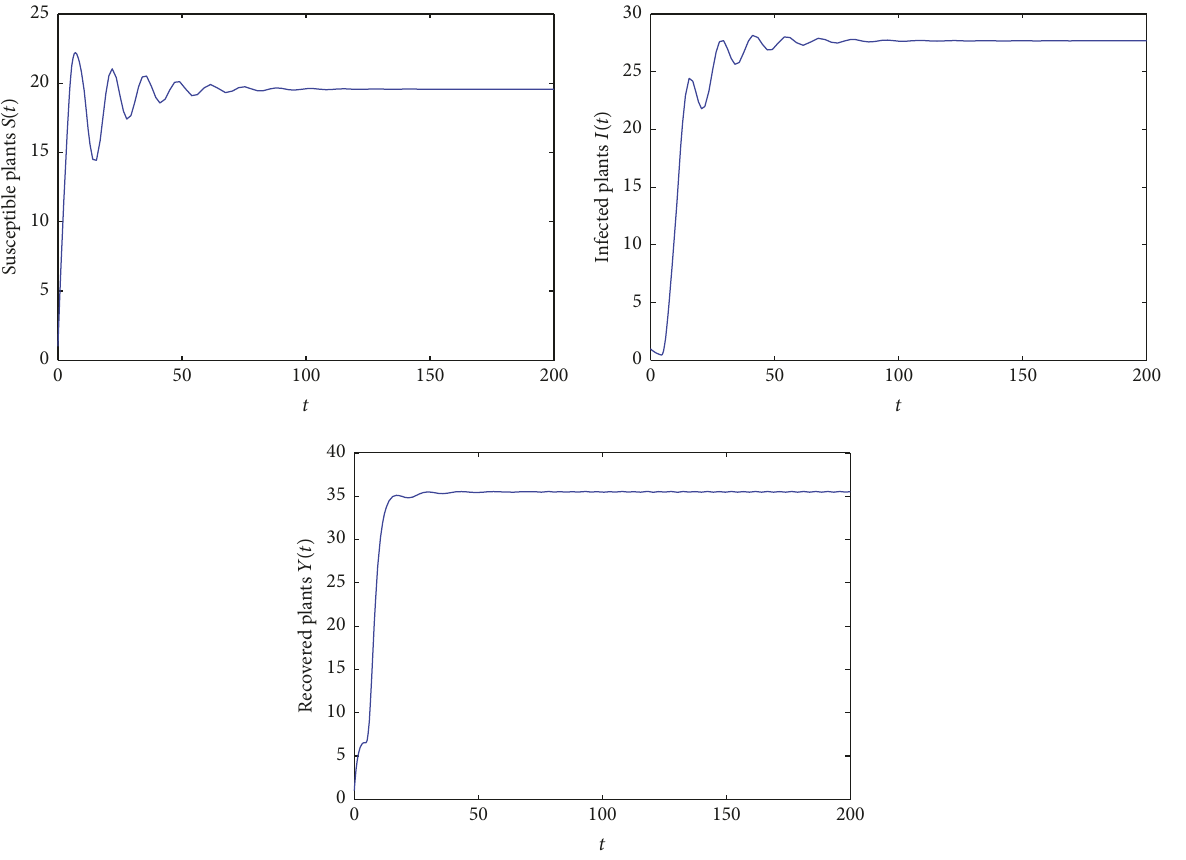
Figure 1: 𝐸 ∗ is asymptotically stable, where 𝜏 1 = 4.3 < 𝜏 ∗ 10 = 4.4686 and 𝜏 2 = 0